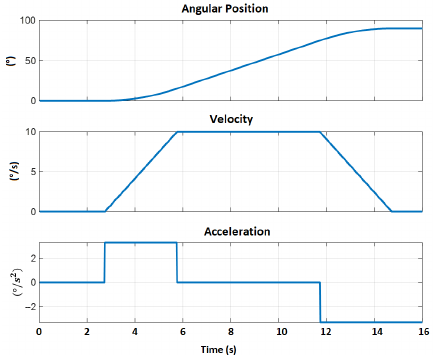
Figure 17. Speed profile applied to each motor from the STM32